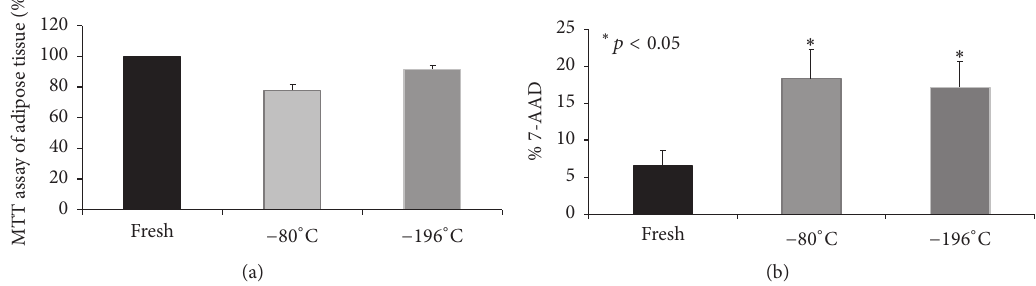
Figure5:Cryopreservationat − 80 ∘ Cand − 196 ∘ CguaranteedviabilityofadiposetissueandATD-MSCs.Thepercentagesofviabilityofadipose tissue normalized on fresh sample are reported (a). 7-AAD staining showed a significant increase of dead cells in cryopreserved compared to fresh samples, 𝑝 < 0.05 , but there was not any difference between the two temperatures of cryopreservation (b).